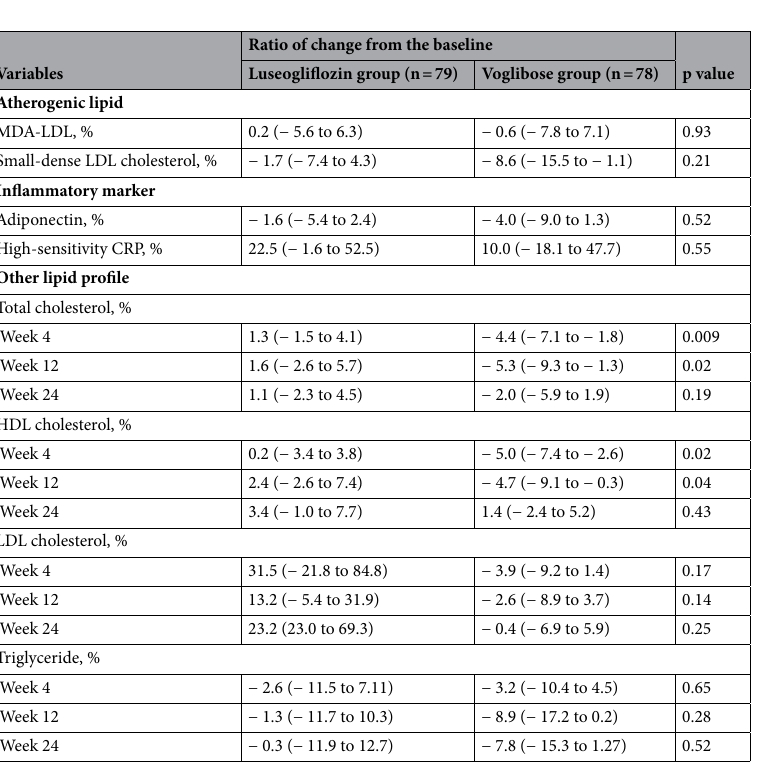
Table 2. Change ratio in biomarkers between the luseogliflozin and voglibose groups. Data are presented as the mean (95% confidence interval). CRP C-reactive protein, HDL high-density lipoprotein, MDA-LDL malondialdehyde low-density